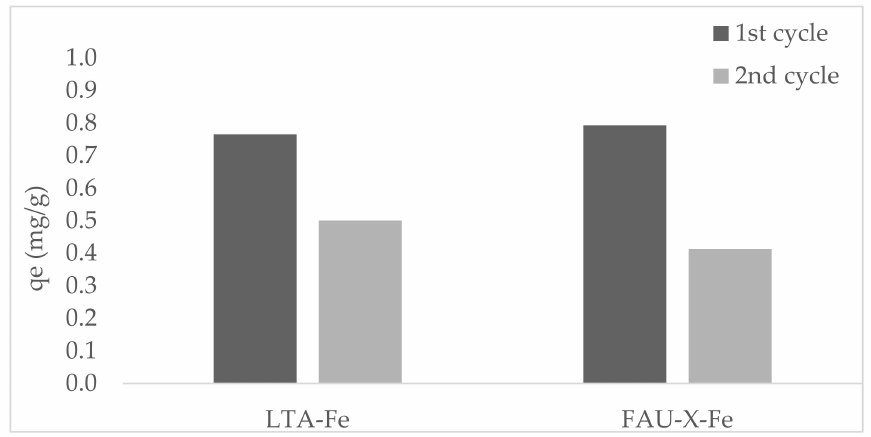
Figure 8. Phosphate capacity in two continuous adsorption-desorption cycles for LTA-Fe and FAU-X- Fe (V: 25 mL, w: 0.25 g, and C i : 25 mg PO 43 − L − 1 ).